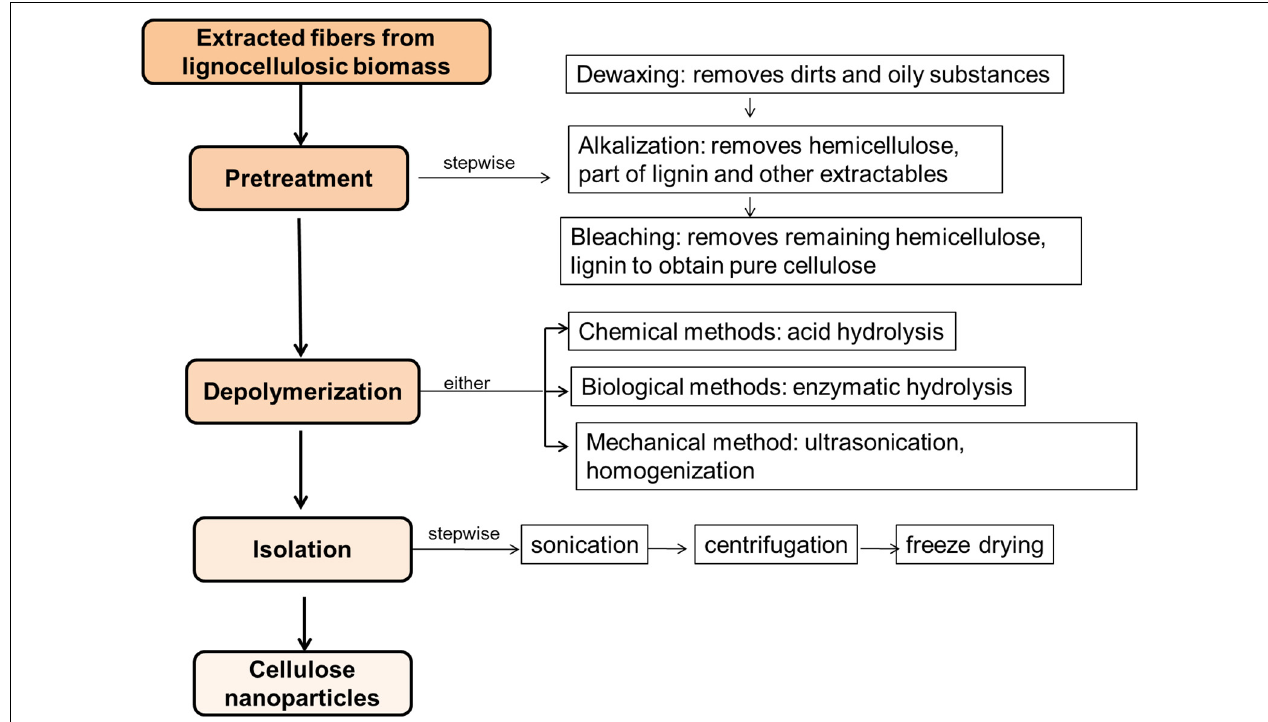
FIGURE 3 | Schematic showing the chemical processes involved in the extraction of nanocellulose starting with untreated fibers.